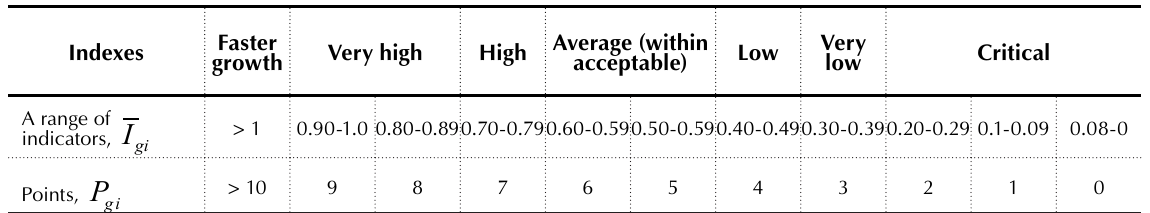
Source: developed by